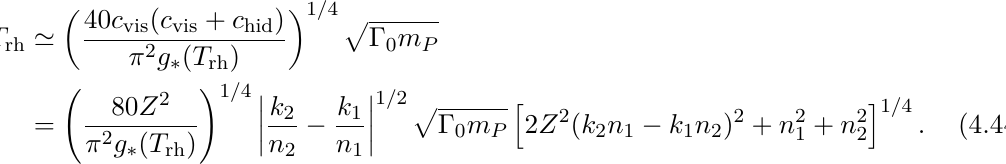
= 0 and k = 1 under the interchange n 1 2 1 ↔ n 2